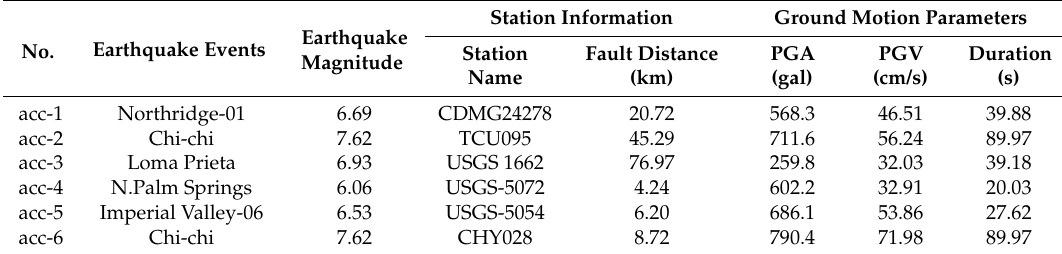
Table 3. Ground Motion